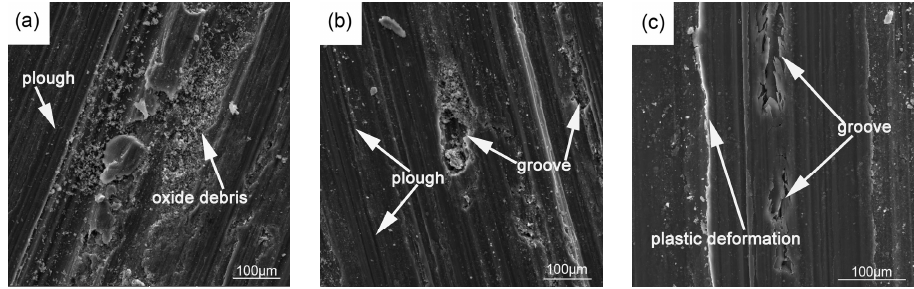
Figure 11. SEM images of worn surface for AZ91-0%Pr alloy under different applied loads ( a ) 30 N, ( b ) 60 N and ( c ) 90 N.